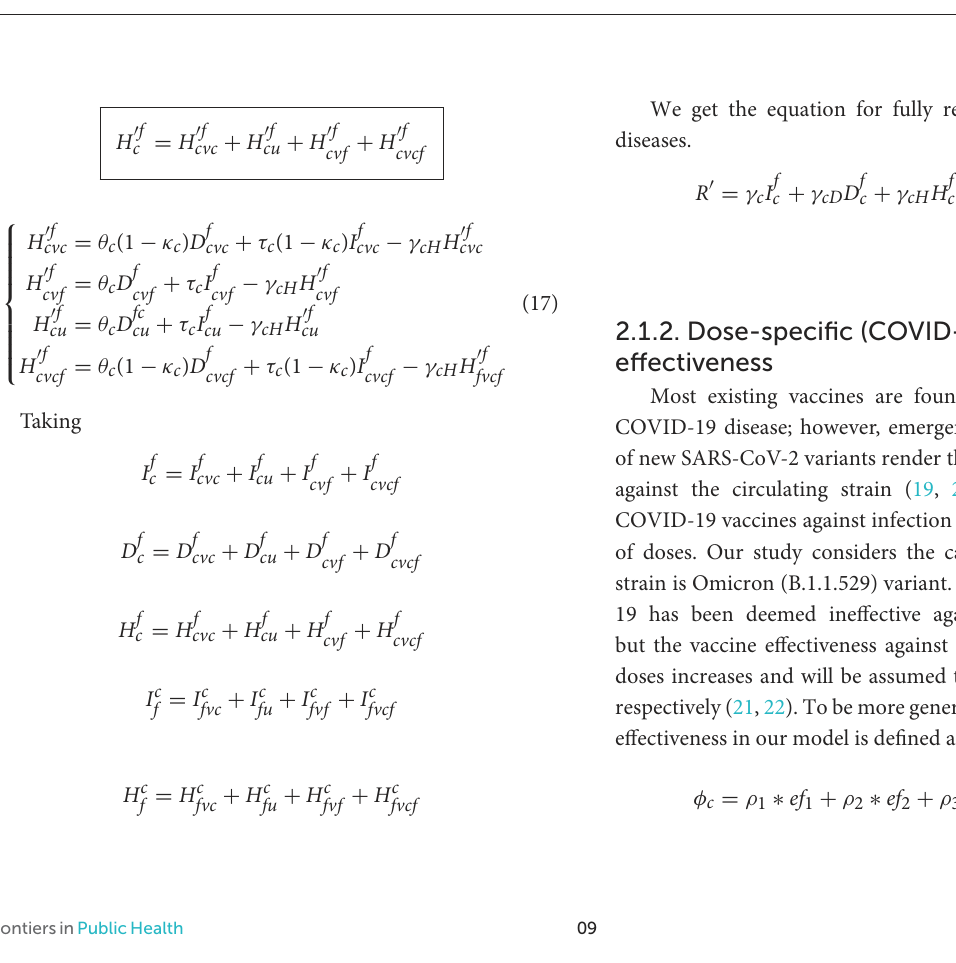
FIGURE4 A plot with high resolution for the case in Figure 3 for 30 days. Note that the scale of infections in this plot is some orders of magnitude smaller than in Figure